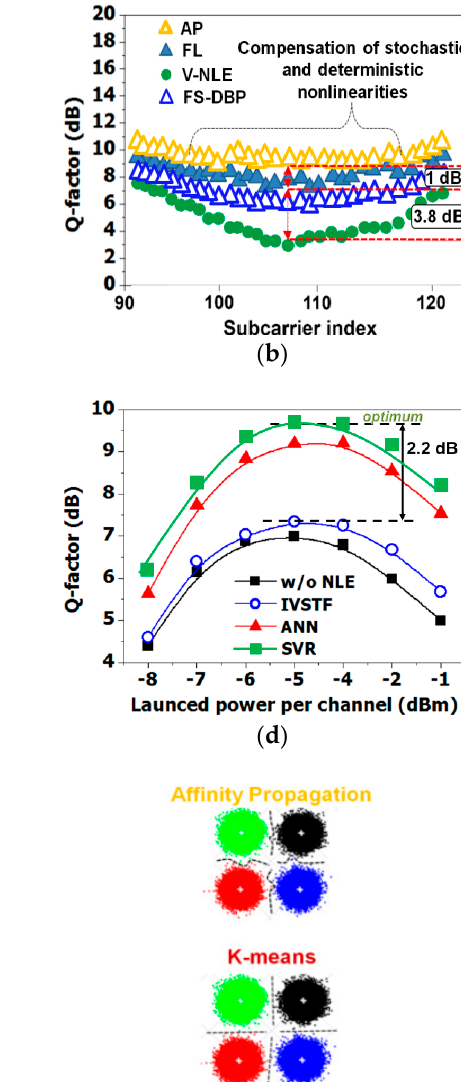
Figure 10. Training overhead evolution example at − 5 dBm of launched optical power (LOP) per channel for supervised support vector machine ‐ regression (SVR) and artificial neural network (ANN). Inset: received optical spectrum of wavelength ‐ division multiplexing (WDM) CO ‐ OFDM system [22,28].